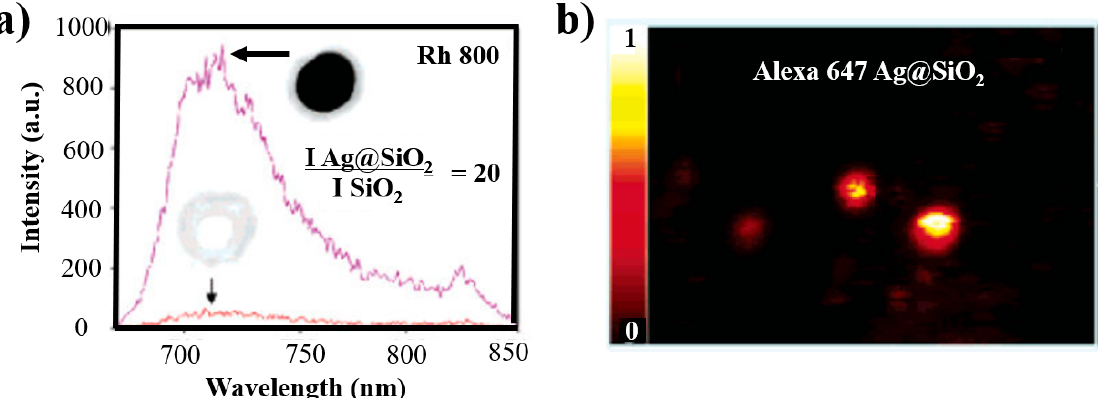
Figure 32. ( a ) Fluorescence emission of Rh800-doped Ag@SiO 2 . ( b ) Scanning confocal images (20 µm × 20 µm) of Alexa 647 Ag@SiO 2 [124].